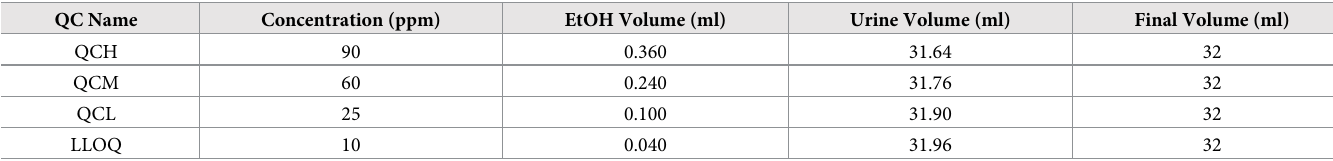
Table 5. Preparation details for QC